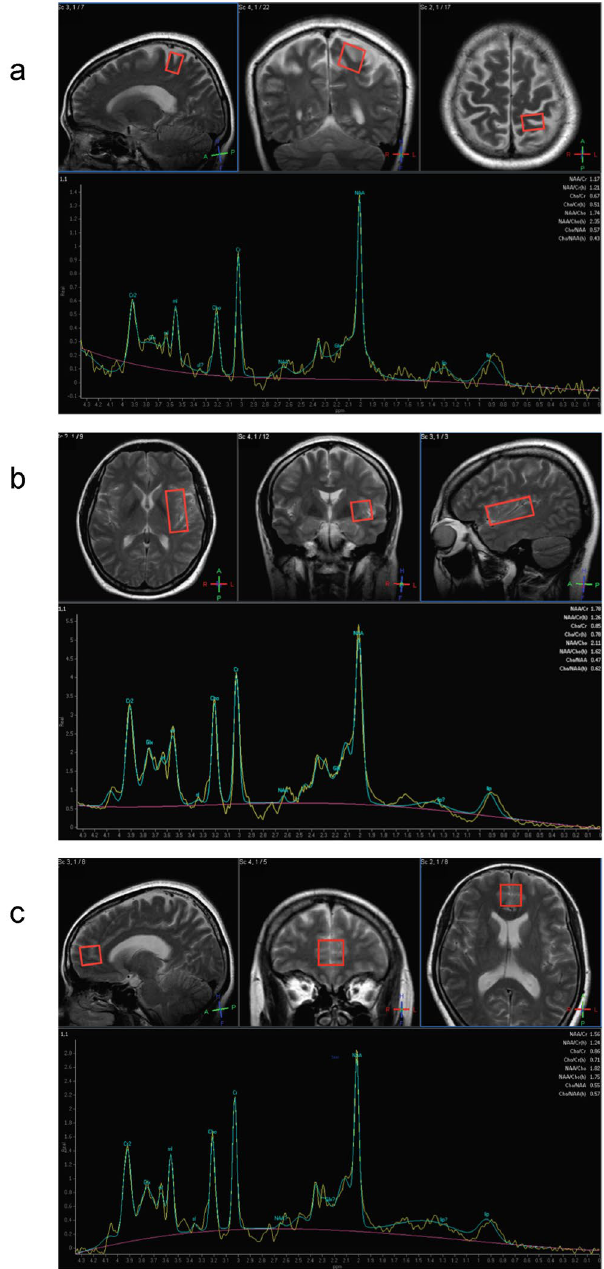
Figure 1. MRS Voxels of Interest ( a ). Left Somatosensory Cortex (20 mm × 15 mm × 20 mm) Voxels were placed on the left post-central gyrus (Brodmann areas 1, 2 and 3) 42 . ( b ) Left Insula (20 mm × 40 mm × 20 mm) Voxels were aligned along the edge of the insula cortex in an anterior-posterior direction with the anterior edge of the volume of interest aligned to the anterior limit of the insula 35 . ( c ) Bilateral pgACC (20 mm × 20 mm × 20 mm) represented the DMN, which interacts with SN to regulate self-focus, and shown to have reduced pain-related activation in FD-PDS 17 . Voxels were positioned as bordering the lower edge of the genu of the corpus callosum and with its posterior limits just touching the anterior border of the genu of the corpus callosum 56